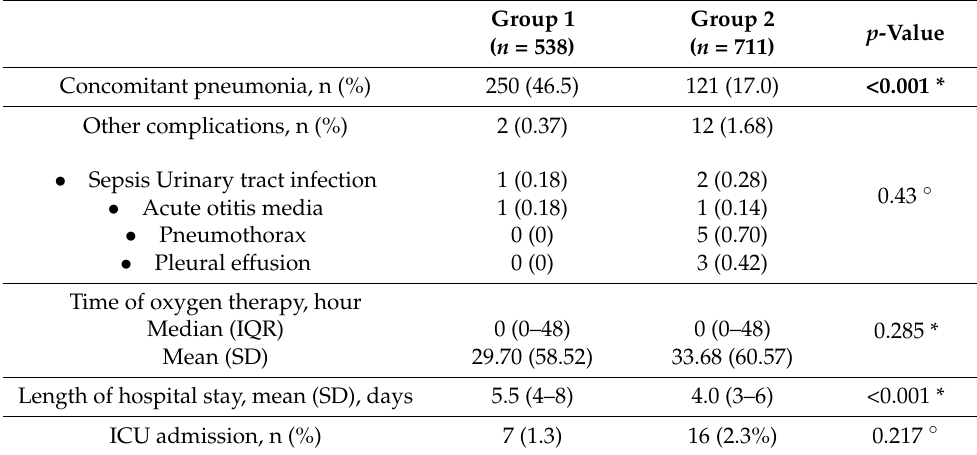
Table 5. Secondary endpoints in the different population